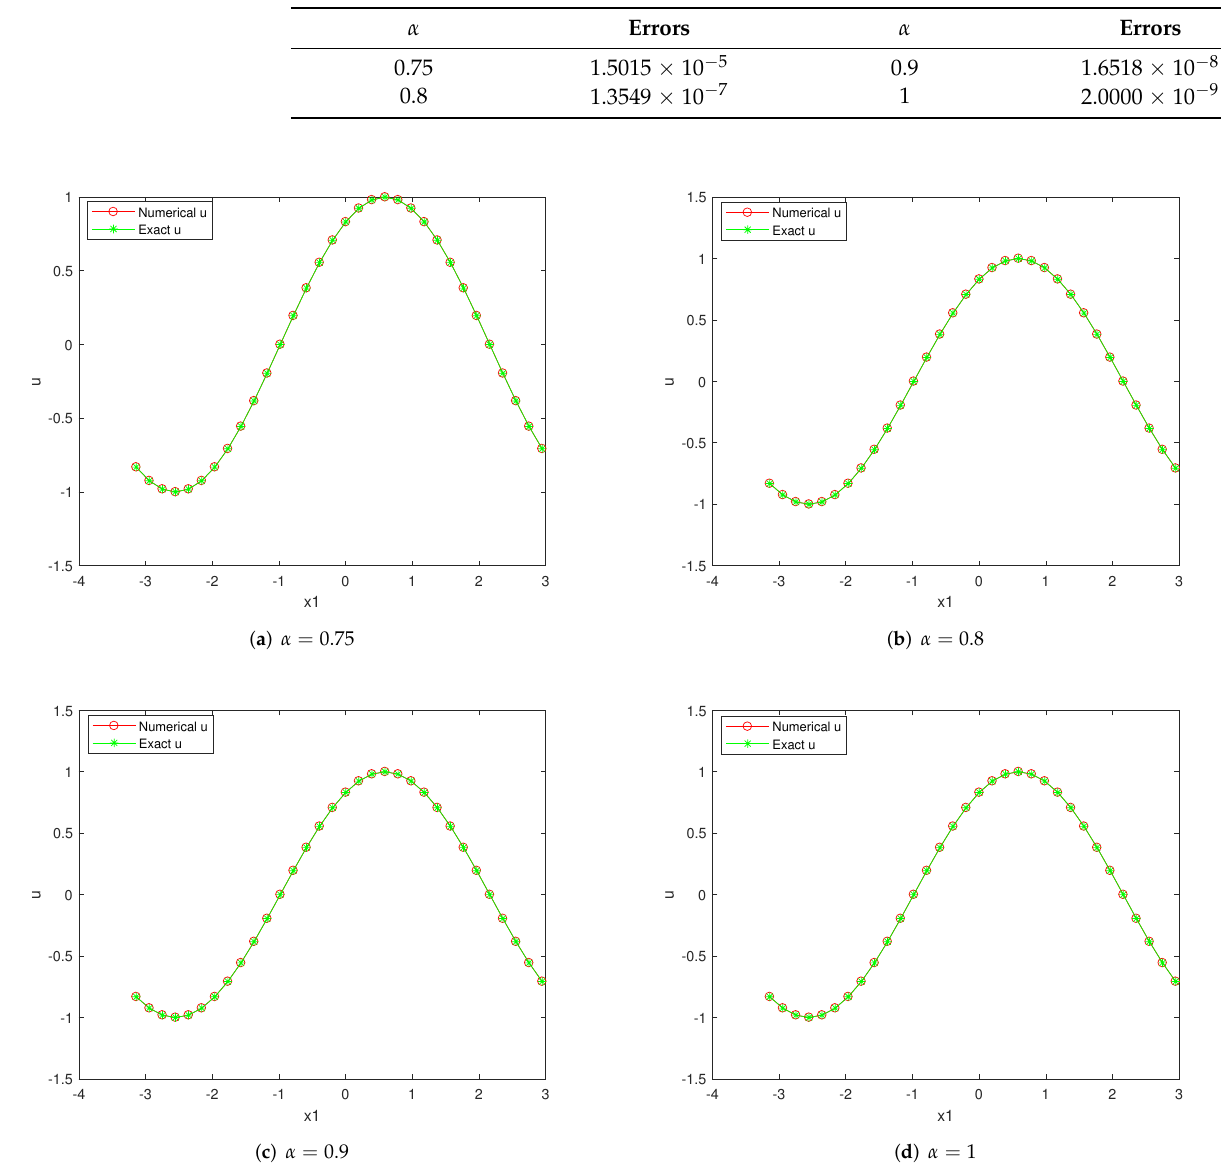
Table 2. The maximum absolute errors between the numerical solutions and the exact solutions in Equation (86) for different fractional order α .